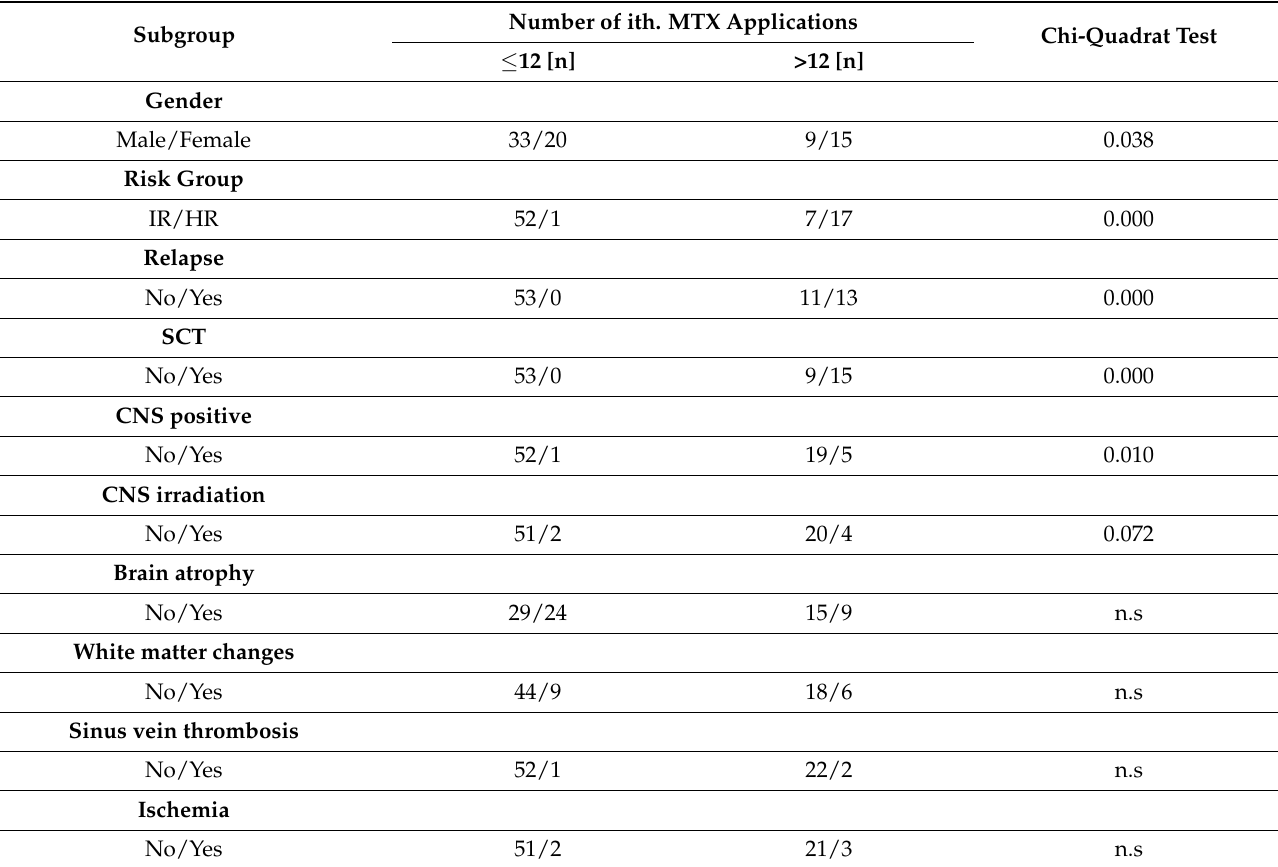
Table 2. Number of ith. MTX applications ( ≤ 12 vs. >12) in patients with ALL and their correlation to risk factors and morphological changes in cMRI. (SCT: hematopoietic stem cell transplantation).